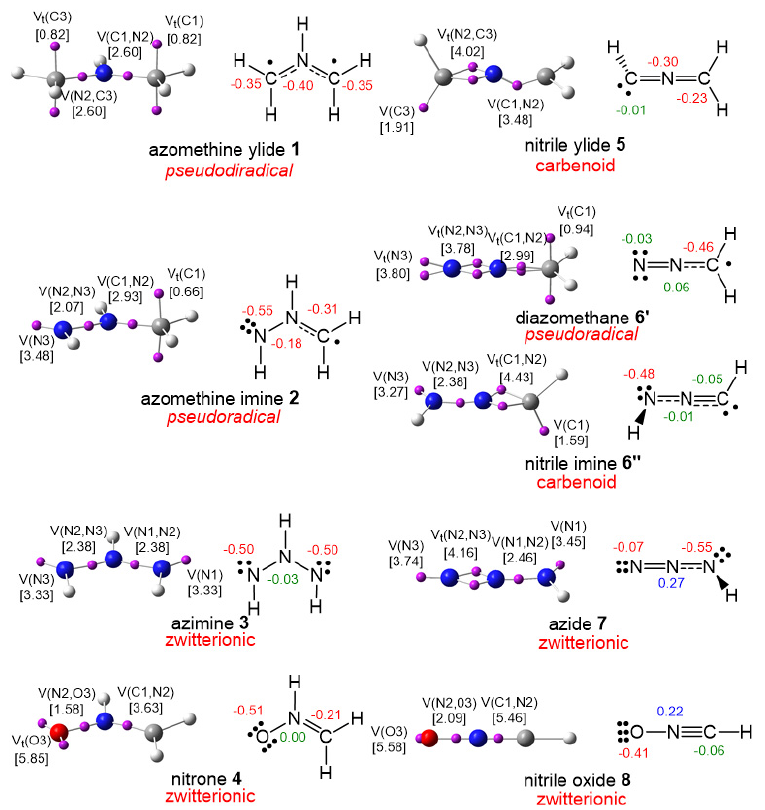
Figure 2. ELF basin attractor positions, ELF-based Lewis-like structures and TAC types, together with calculated natural atomic charges, in number of electrons e, of TACs 1 – 8 . Negative charges are colored in red, positive charges in blue and negligible charges in green.